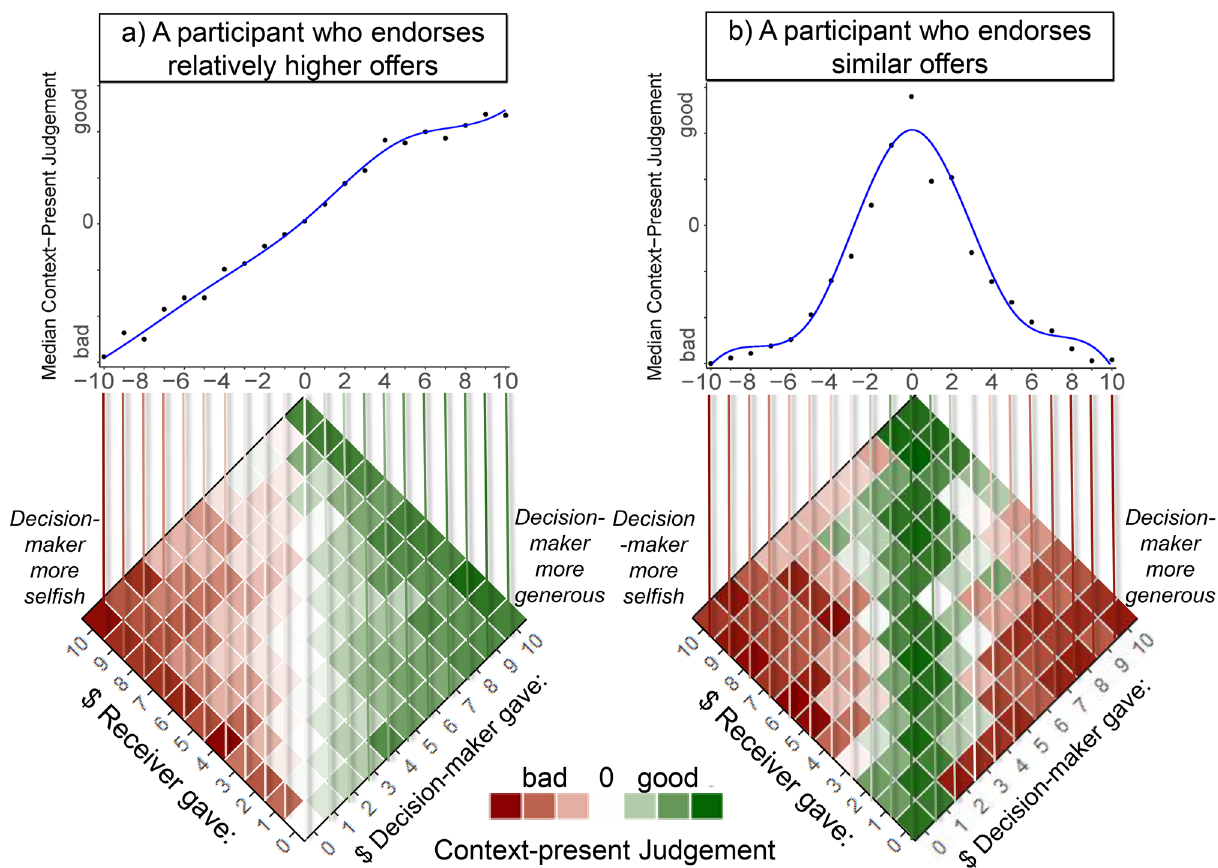
Figure 4. Context-present Judgements for a range of Decision-makers’ offers relative to Receivers’ (− 10 to 10). Plotted in ( a , b ) are examples of two participants. Each point on the scatter plot represents the median judgement value over the corresponding groups of tiles in the tile-plot (also see Fig. 3). This correspondence is designated using vertical coloured lines. The blue line in the scatter plot represents a smooth functional data analysis fit over the median judgement